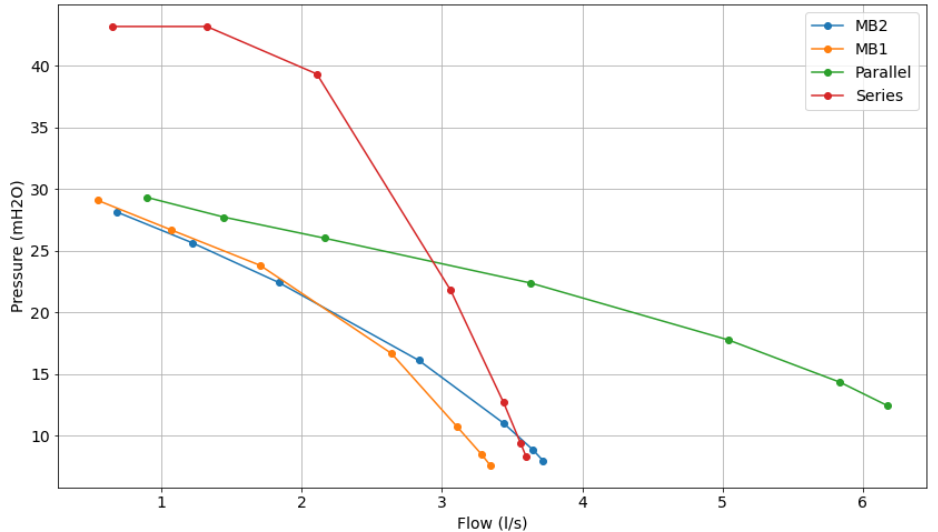
Figure 11. Comparative characteristic curve of pumps operating at 50